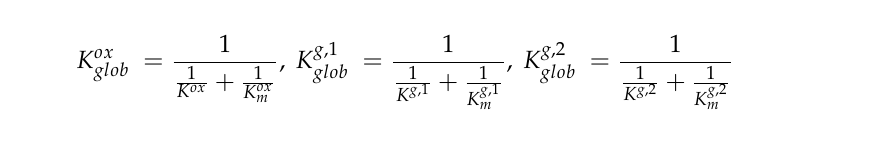
Table 1. Kinetics of the solid heterogeneous